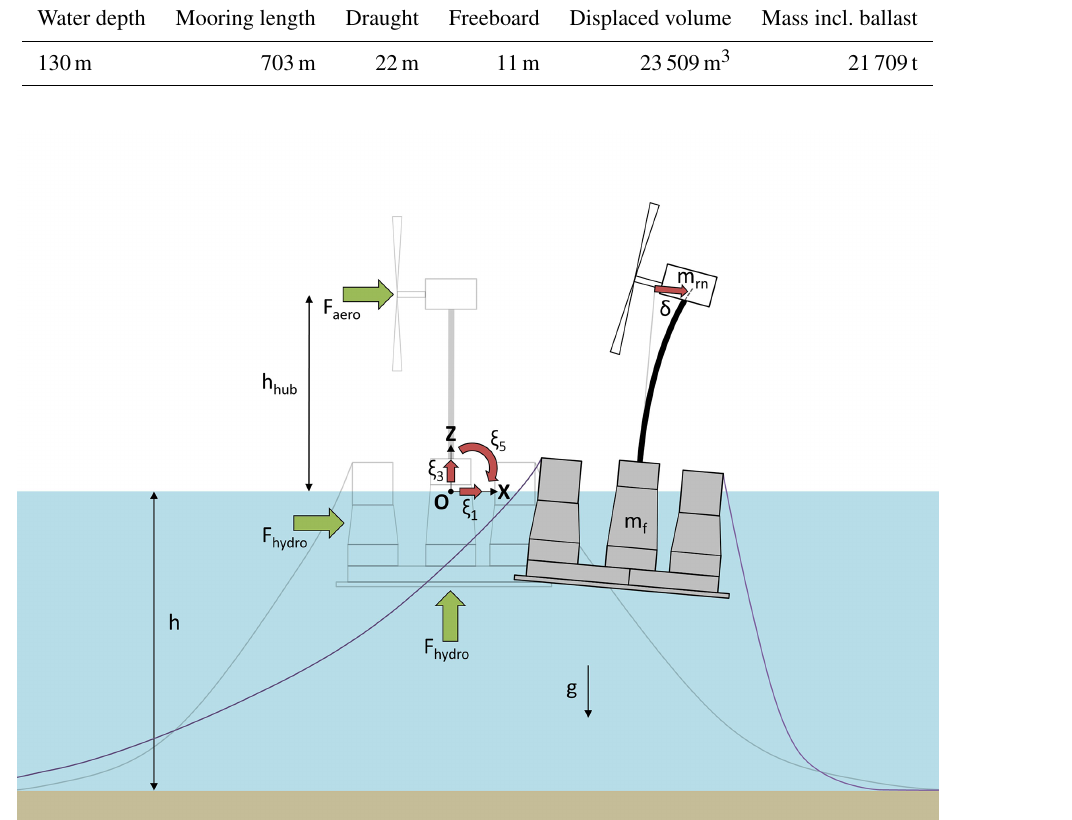
Figure 3. Sketch of the floating wind turbine as seen by the QuLAF